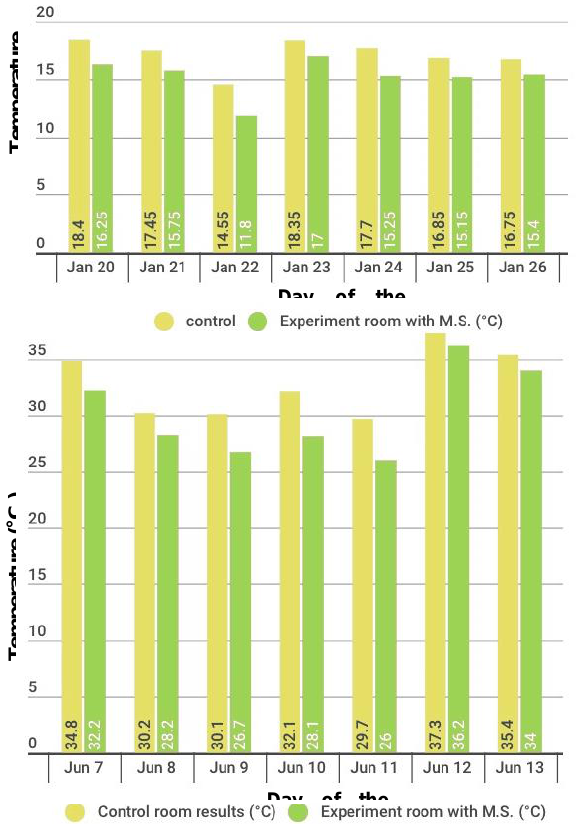
Figure 9. The figure represents the temperature outcomes for both the control room and experiment room during the hottest and coldest times of the